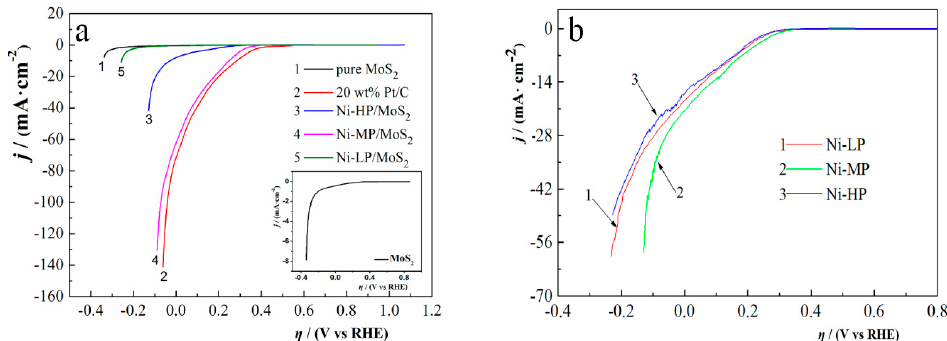
Figure 4. Linear sweep voltammetry (LSV) curves of the samples: ( a ) pure MoS 2 , 20 wt % Pt/C, Ni–LP/MoS 2 , Ni–MP/MoS 2 , and Ni–HP/MoS 2 . Scan rate: 2 mV/s, potential window: − 0.3~0.8 V (vs. RHE); ( b ) Ni–LP, Ni–MP, and Ni–HP. Scan rate: 2 mV/s, potential window: − 0.4~0.8 V (vs. RHE). Table 1. The obtained values of onset overpotentials (OVP), Tafel slope ( b ), symmetry factor ( β ), and active site ( n ).